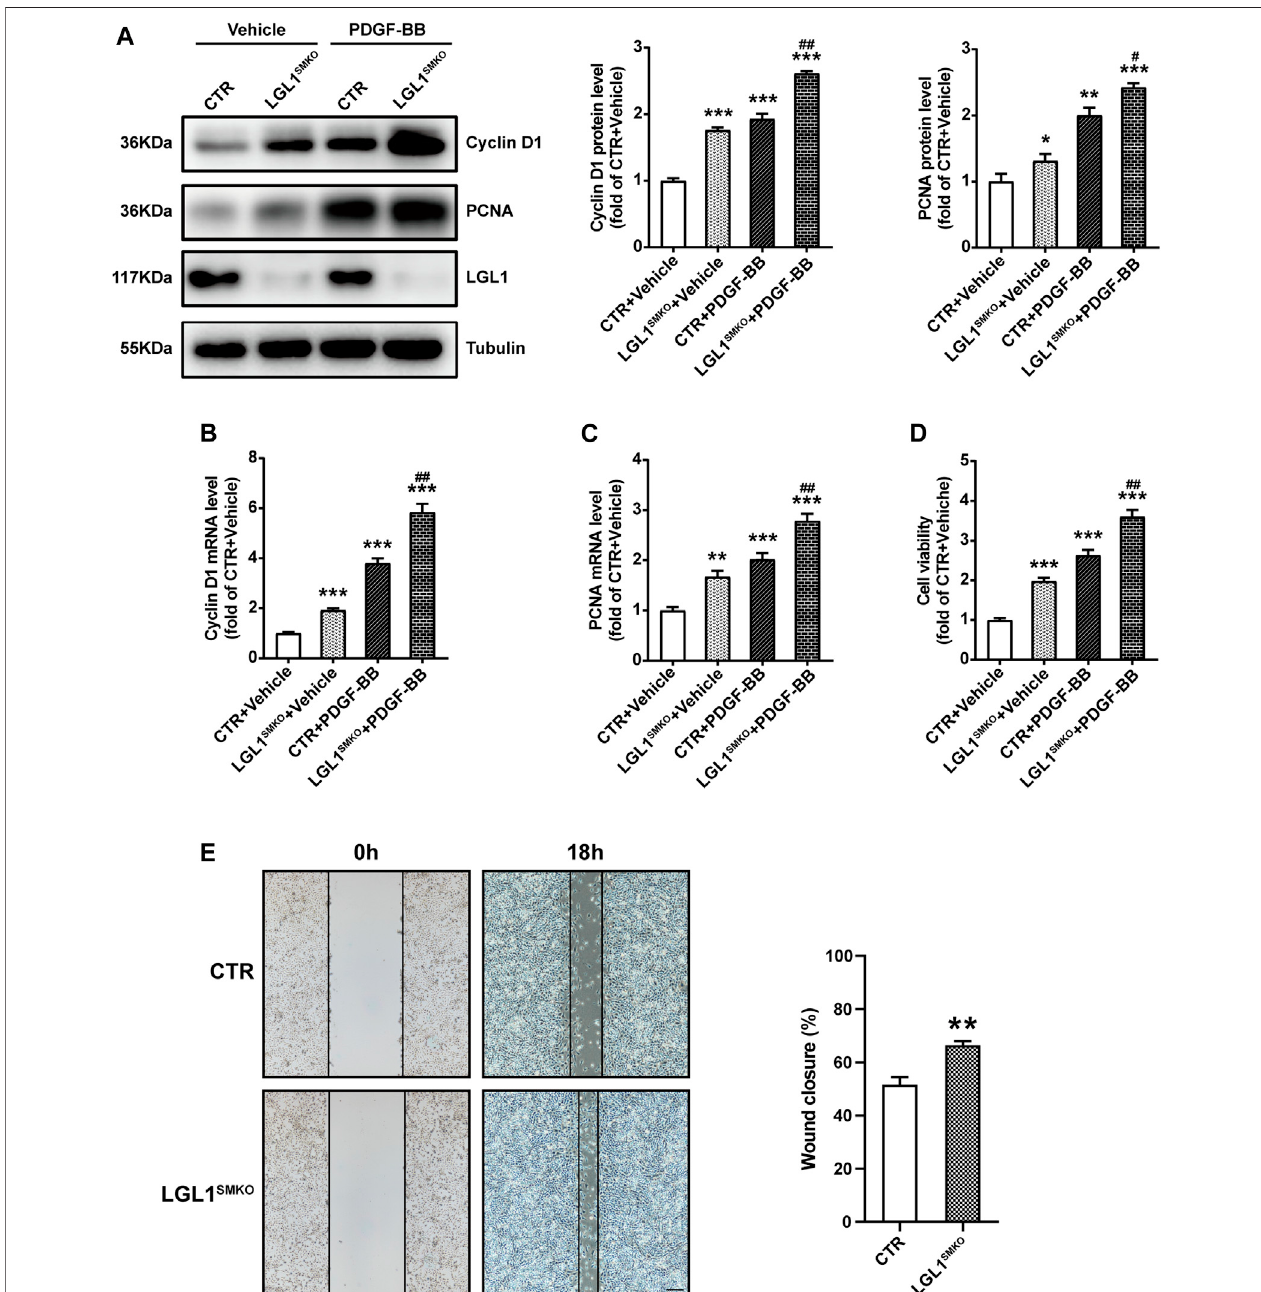
FIGURE 3 | LGL1 de fi ciency promoted the proliferation and migration of VSMCs. (A) Primary VSMCs were cultured from control (CTR) and LGL1 SMKO mice and treated with PDGF-BB for 48 h. The protein levels of Cyclin D1 and PCNA were detected by western blot analysis ( n = 3). * p < 0.05, ** p < 0.01, *** p < 0.001 vs. CTR + Vehicle. # p < 0.05, ## p < 0.01 vs. CTR + PDGF-BB. (B,C) mRNA levels of Cyclin D1 (B) and PCNA (C) tested by qRT-PCR ( n = 4). ** p < 0.01, *** p < 0.001 vs. CTR + Vehicle. ## p < 0.01 vs. CTR+PDGF-BB. (D) CellproliferationmeasuredbyCCK-8assay( n =5).*** p < 0.001 vs. CTR+Vehicle. ## p < 0.01 vs. CTR+PDGF-BB. (E) Cell migration evaluated by scratch wound healing assay ( n = 4). Wound closure (%) represented migrative ability. Scale bar: 200 μ m. ** p < 0.01 vs. CTR.